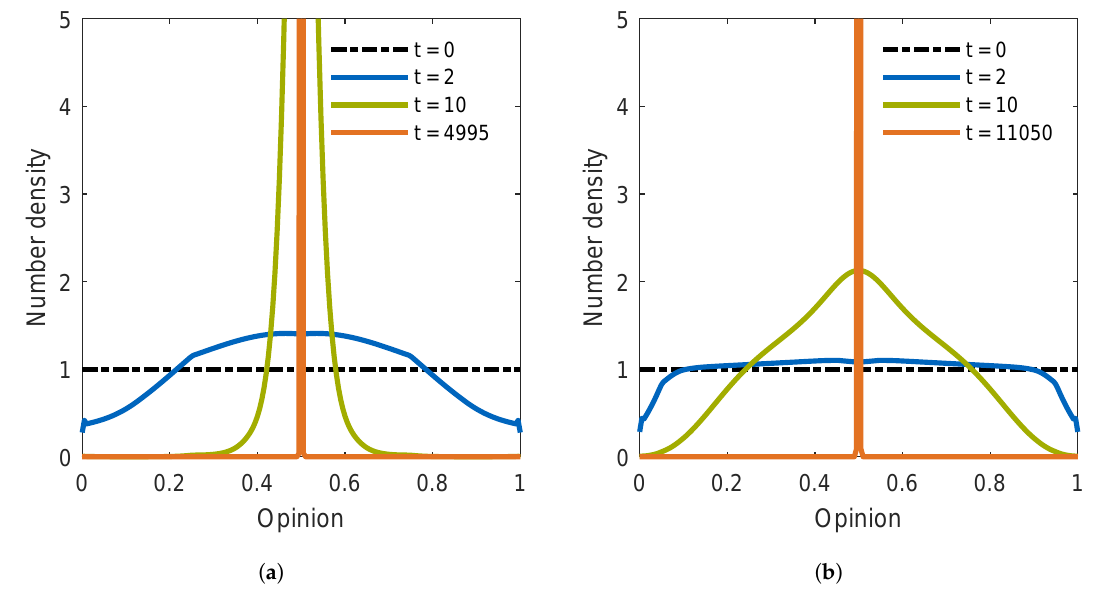
Figure 2. Time evolution of number density n of opinions for bounded confidence parameter d = 0.5; results for convergence parameter µ = 0.5 ( a ) and µ = 0.1 ( b